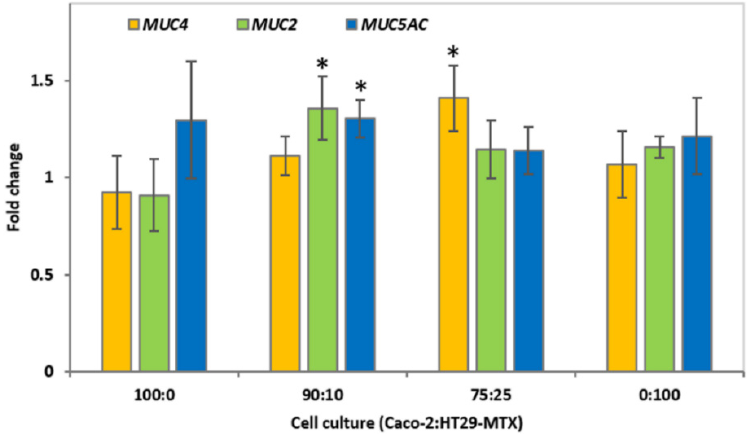
Figure 3. Relative fold change of MUC mRNA from epithelial cell cultures incubated with 4 mg/mL caprine milk oligosaccharide ‐ enriched fraction (CMOF). The expression of mucin genes MUC4 , MUC2 and MUC5AC by 100:0, 90:10, 75:25, and 0:100 Caco ‐ 2:HT29 ‐ MTX cell cultures after 12 h incubation with 4.0 mg/mL CMOF, compared to respective control monolayers. The data are expressed as the mean fold change (±SEM) of three replicates across three independent experiments. A statistically significant difference in fold change is indicated by * ( p < 0.05 ).